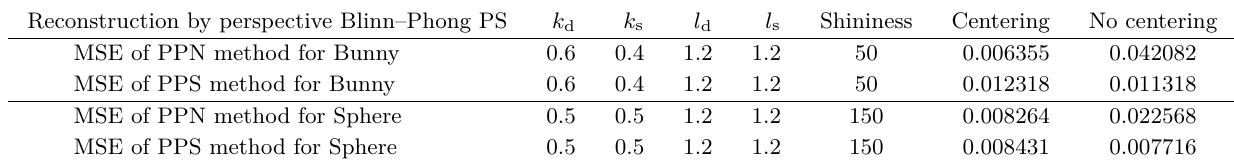
Table 2 MSE in depth reconstructed from images with specularities, using PPN and PPS methods. We consider 3D reconstruction in the presence of simultaneous diffuse and specular reflections from the surface which leads to involving both k d and k s using a complete Blinn–Phong model